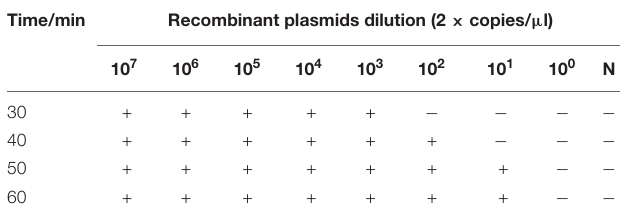
TABLE 4 | Reaction temperature optimization for RT-LAMP-VF. TABLE 5 | Reaction time optimization for the RT-LAMP-VF assay.